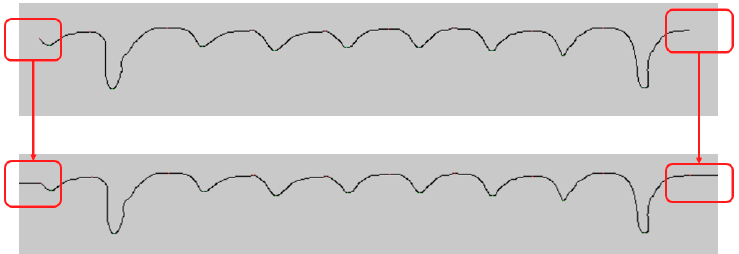
Figure 16. Schematic diagram of pixel expansion.